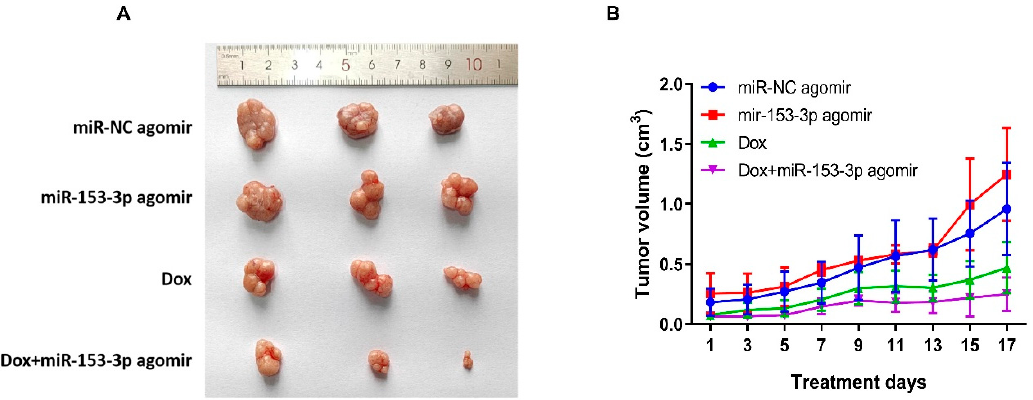
Figure 11. The tumor’s images after treatment with miR-NC agomir, miR-153-3p agomir, Dox, and Dox+miR-153-3p agomir ( A ). The size and volume curves of tumors treated with miR-NC agomir, miR-153-3p agomir, Dox, Dox+miR-153-3p agomir ( B ).